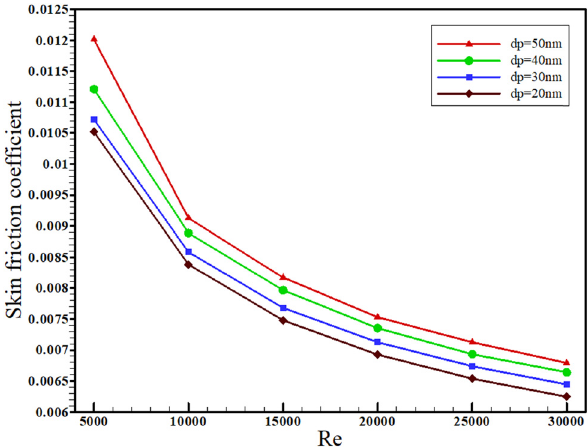
Figure 8: Reynolds numbers and skin friction coe ffi cient variation for various diameters of SiO 2 nanoparticles of water/SiO 2 nano fl uid with ϕ =